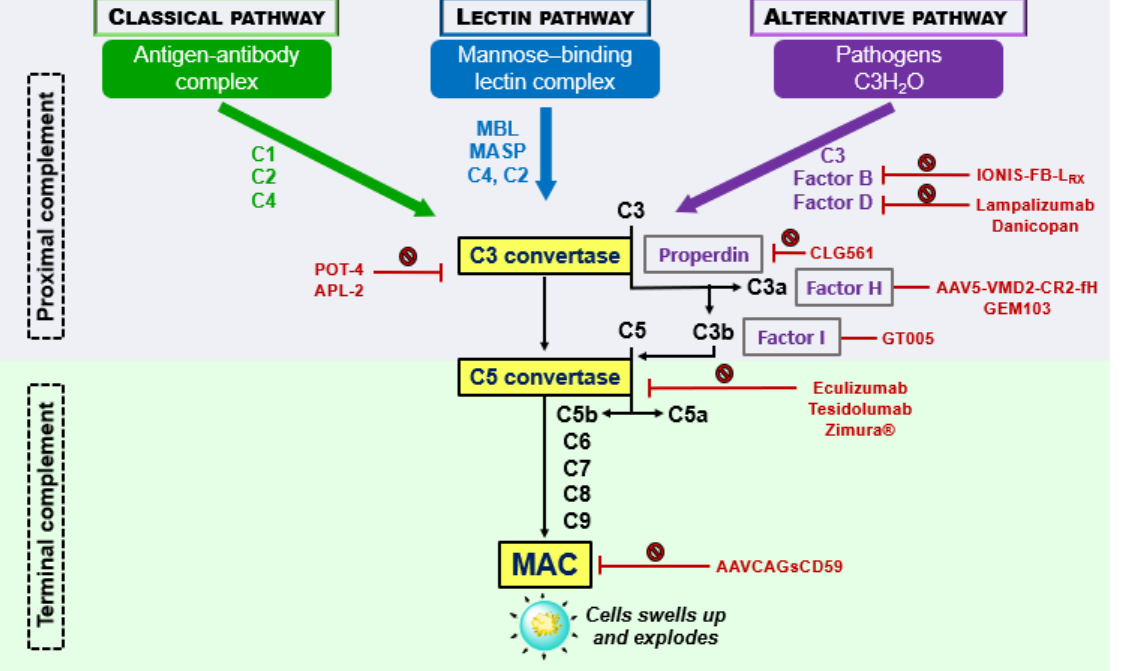
Figure 15. The complement cascade. MBL: mannose binding lectin; MASP: MBL-associated serine protease; MAC: Membrane attack complex. Alternative pathway: linkage of Factor B with the hydrolyzed C3, then cleavage by the Factor D to form the C3 convertase. C3 convertase cleaves and actives the complement C3 for C3a and C3b conversion. Properdin is a positive complement to stabilize C3 and C5 convertases. Factor H intervenes over the C3/C5 dissociation and the Factor I inactives C3b. C5 convertase cleaves and actives the complement C5 for C5a and C5b conversion. C5b, C6, C7, C8 and C9 allow the MAC formation [149].